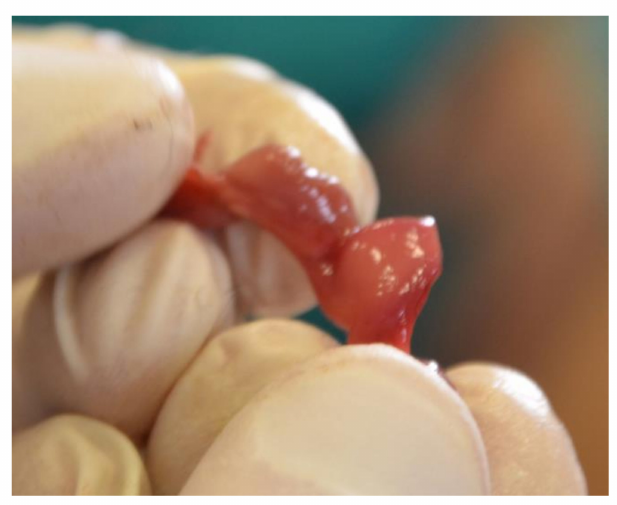
Figure 2. Lymph node. Pre-scapular adenomegaly.